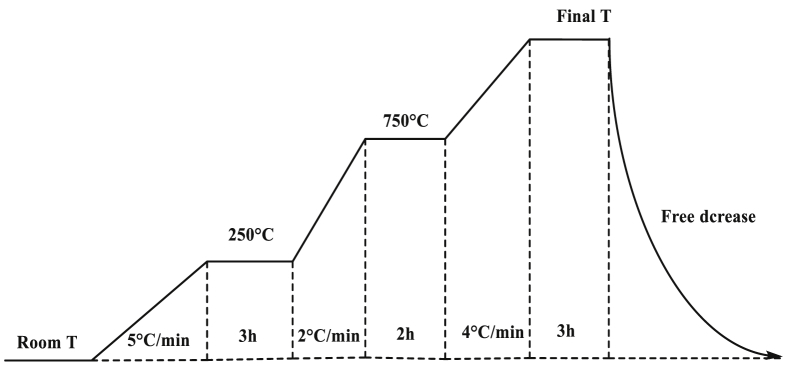
Heating program used to consolidate the clay specimens (Elgamouz and Tijani, 2018a).